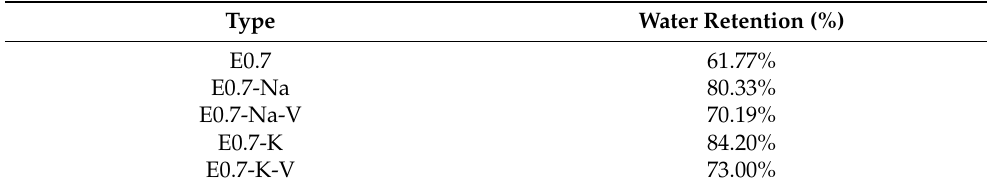
Table 5. Water retention test results.